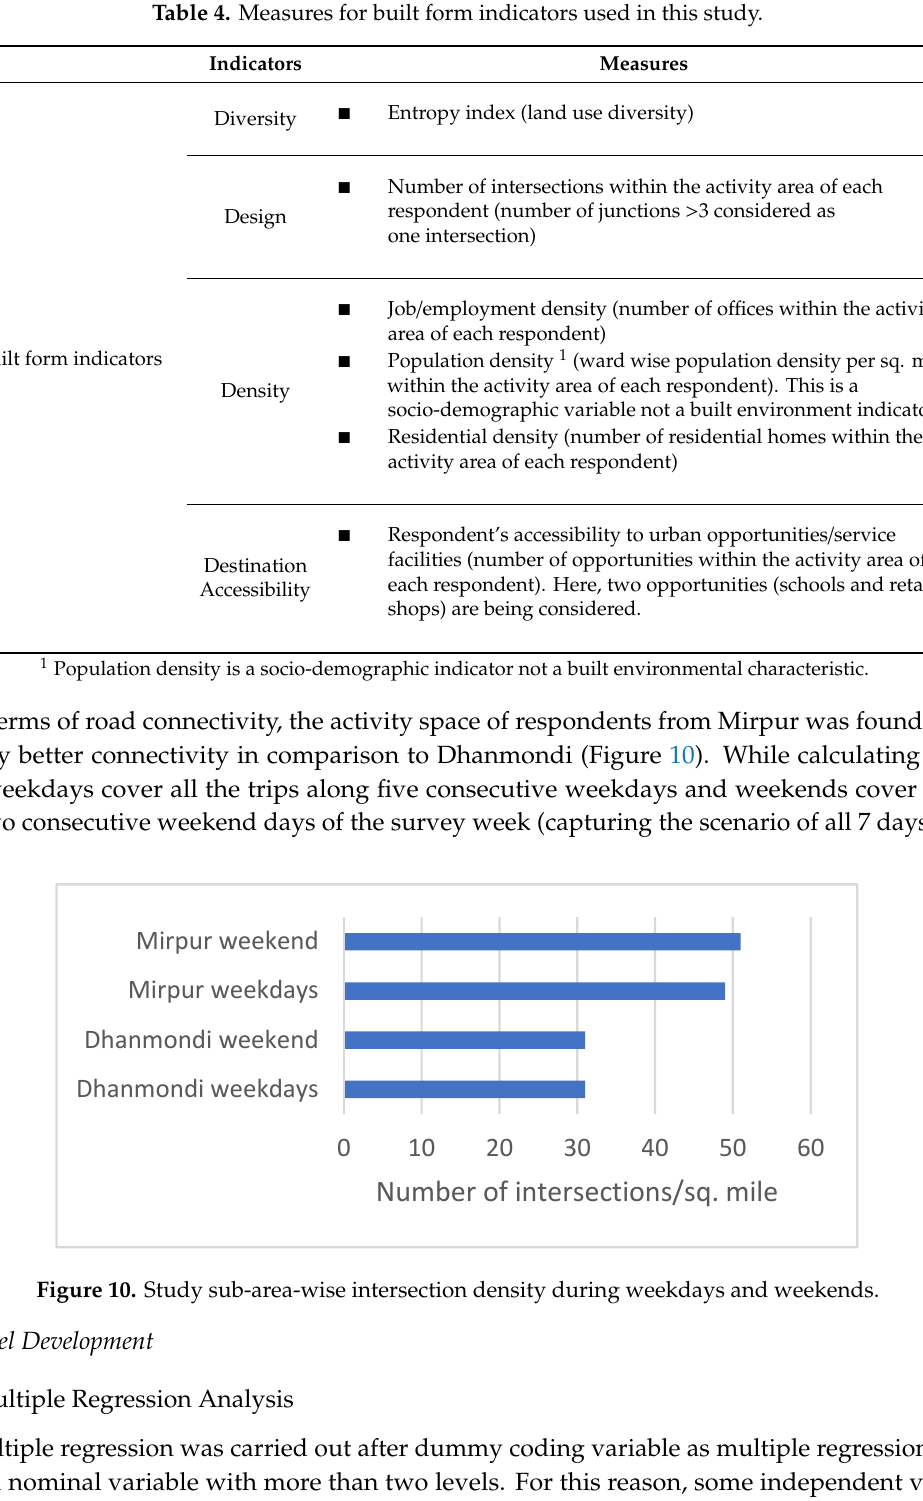
Table 5. Model Summary. Model